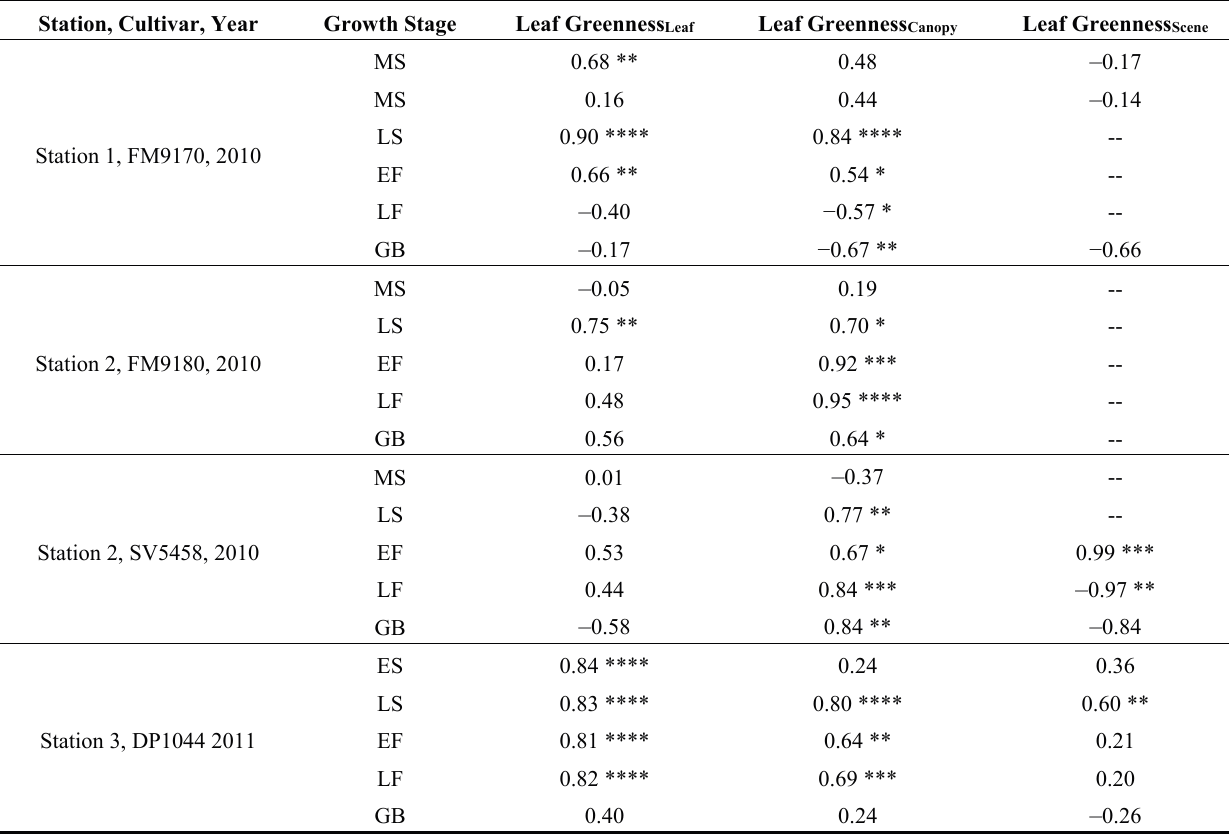
Table 1. Coefficient of Pearson correlation between leaf greenness measured at leaf (Leaf greenness Leaf ), canopy (Leaf greenness Canopy ) and scene (Leaf greenness Scene ) scales with chlorophyll meter readings. Number of samples for weekly correlation analysis was 8, 5, and 10 for Station 1, Station 2 (each cultivars), and Station 3, respectively. In certain weeks, the analysis was not carried out due to insufficient number of